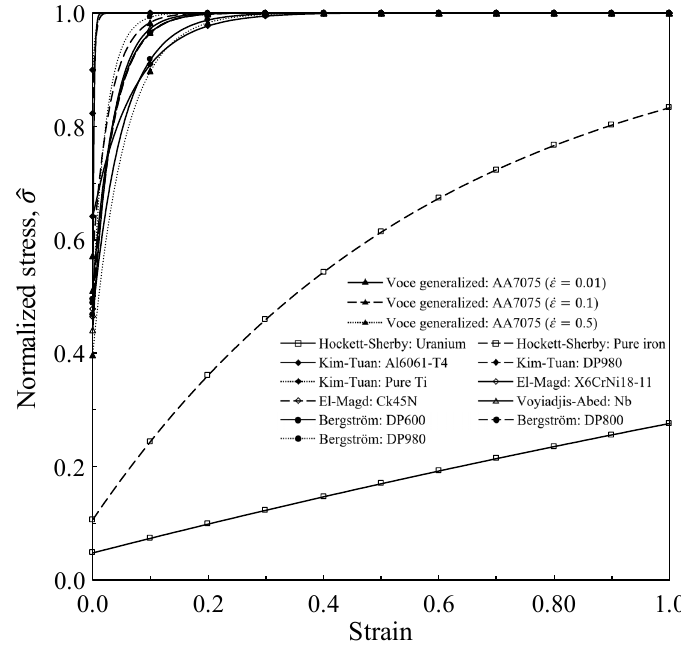
Figure 18. Normalized Voce curves.